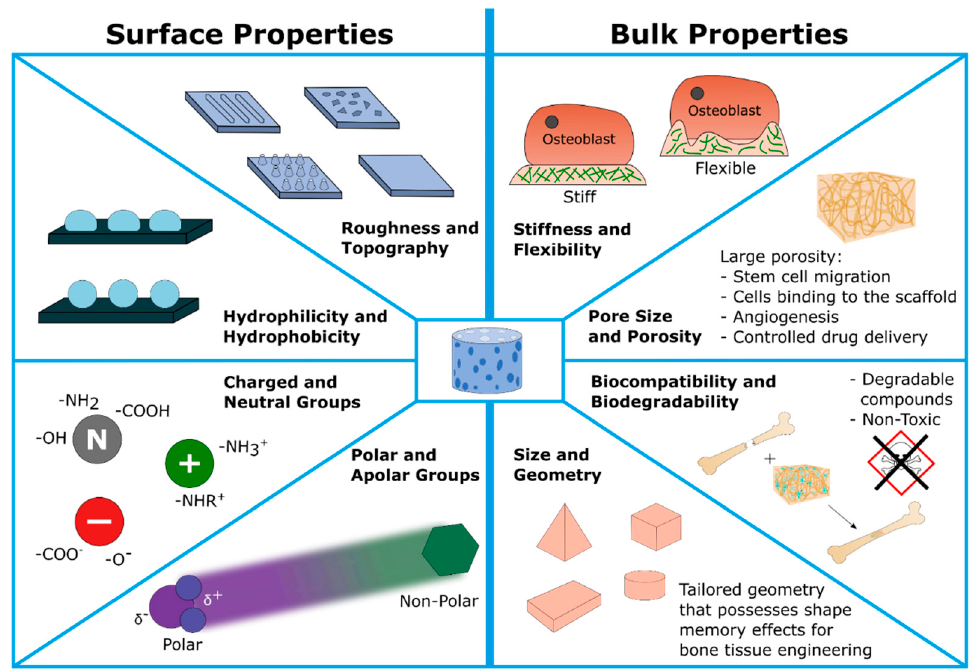
Figure 3. Overview of bone scaffold characteristics. Including: scaffold size and geometry, mechanical strength (stiffness and elasticity), geometry, surface hydrophilicity/hydrophobicity, surface charge, pore size, porosity, and others, modulating the host responses and bone regeneration.